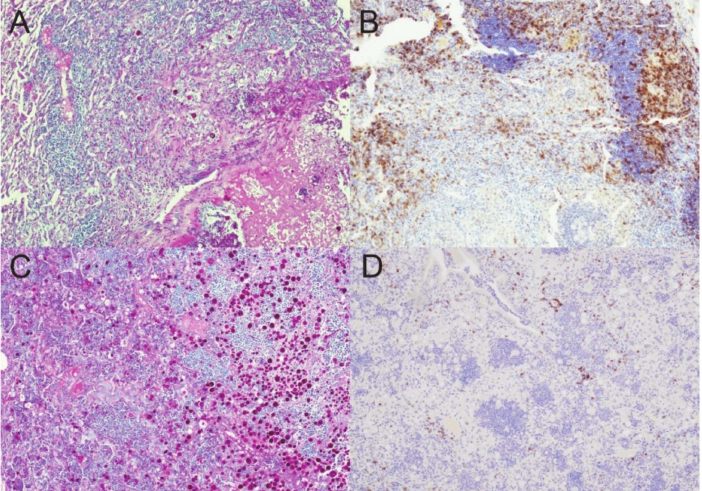
Figure 9. Spherules and T-cells in DXM stop and DXM cont mice. Spherules ( A ) were few and T-cells ( B ) abundant throughout the pyogranulomatous lesions of mice 6 weeks after discontinuing a 14-day course of DXM. By contrast, spherules were numerous ( C ) and T-cells nearly absent ( D ) in mice receiving DXM continuously. (Stain—( A , C )—periodic acid Schiff stains spherules dark pink; ( B , D )—anti-CD3 IHC stains the T-cells brown; magnification ×